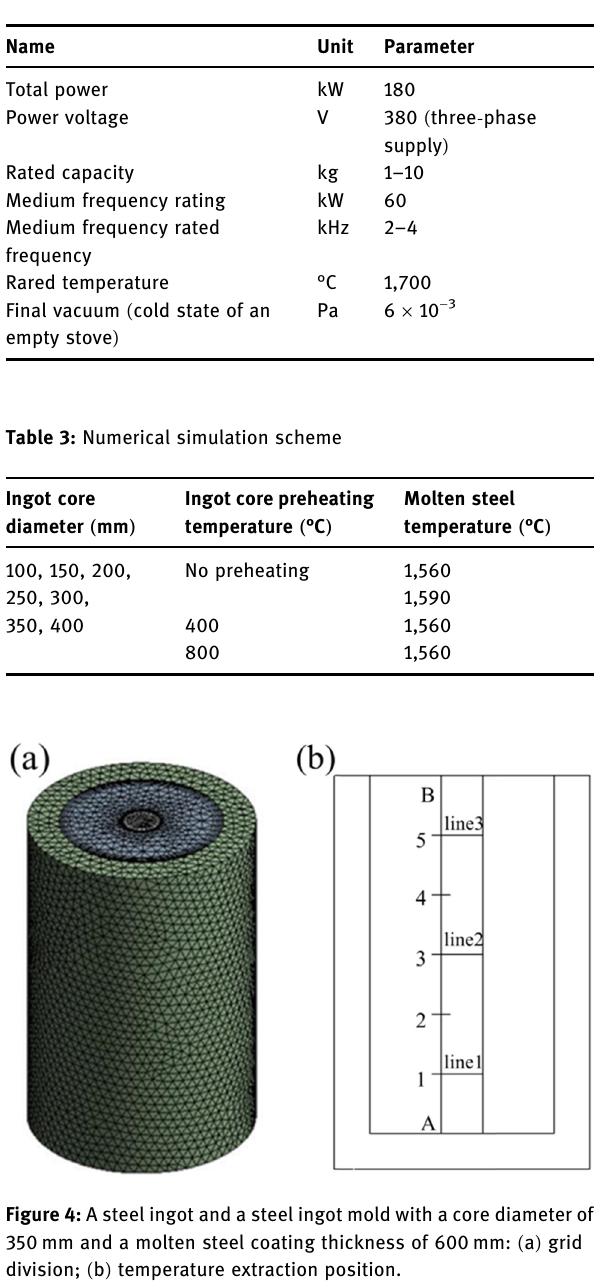
Table 2: Technical parameters of BRY - DZG - 10 multifunctional vacuum melting and casting furnace